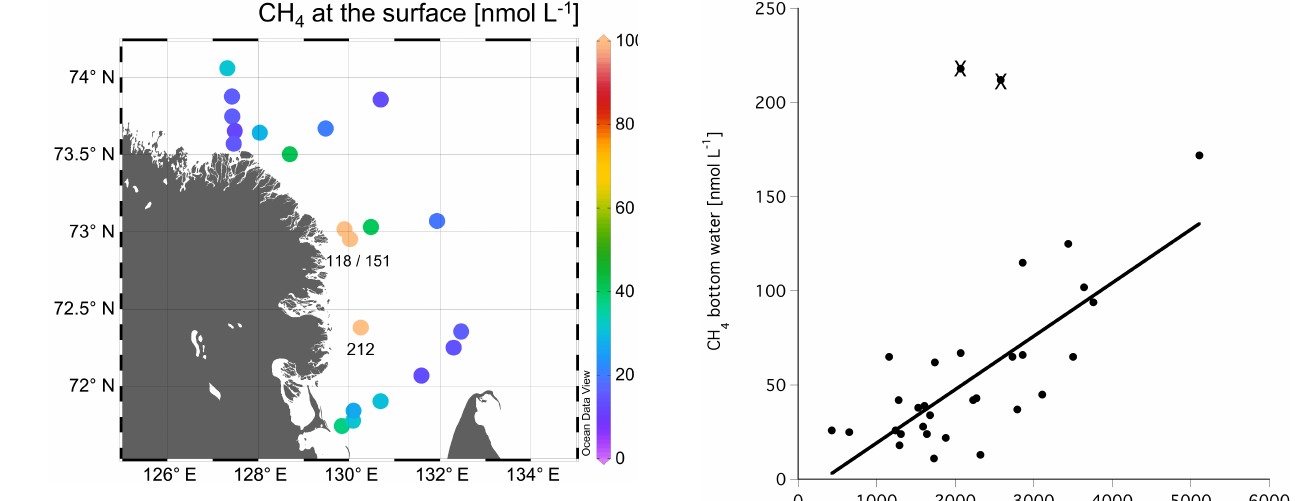
Figure 3. Methane concentrations in nmol L − 1 at the surface of the study area. For stations with very high methane concentrations, the values are annotated in the figure.